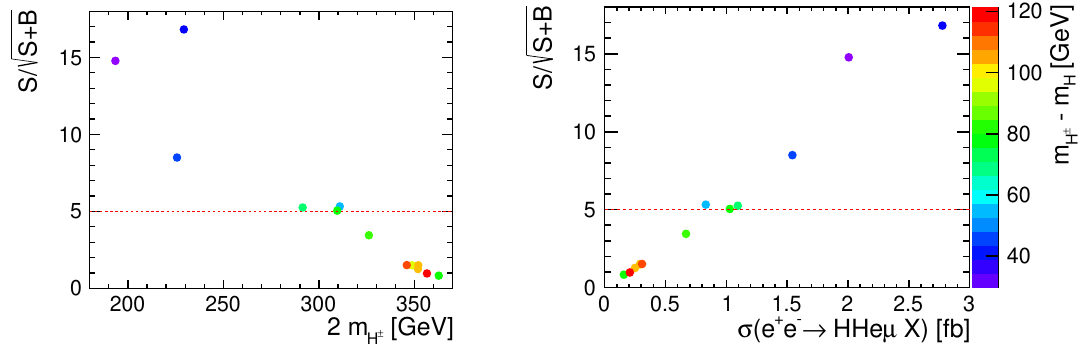
Figure 9 . Expected signi(cid:12)cance of the deviations from the Standard Model predictions observed at 380 GeV CLIC for events with electron-muon pair in the (cid:12)nal state ( e + (cid:22) (cid:0) or (cid:22) + e (cid:0) ) as a function of twice the charged scalar mass (left) and the production cross-section for the considered signal channel (right) , for di(cid:11)erent IDM benchmark points. Color indicates the mass splitting between the H (cid:6) and H scalars (right scale applies to both